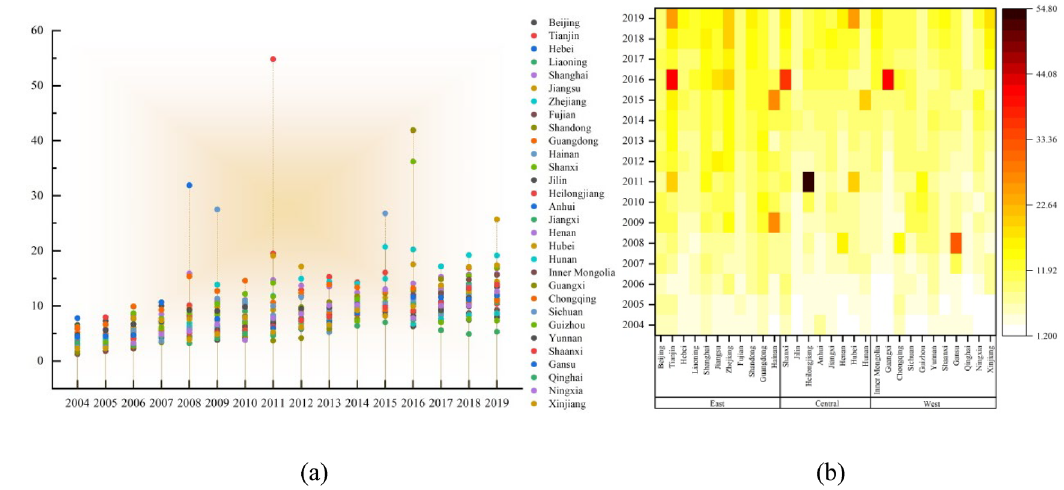
Figure 6. Temporal and spatial characteristics of